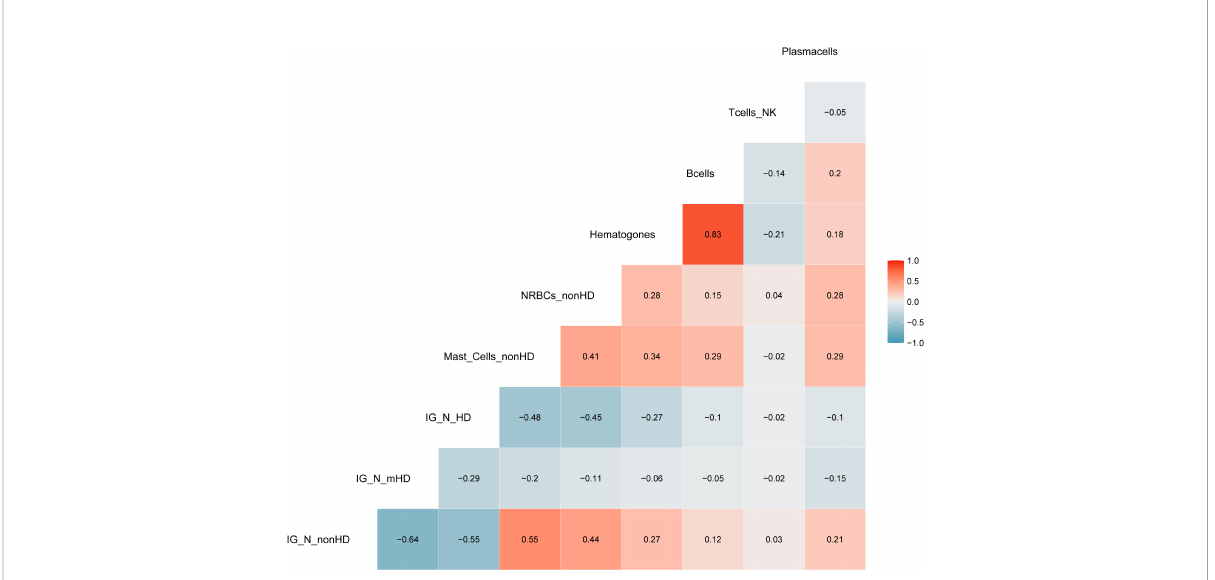
FIGURE 3 Correlation analysis with categorized parameters. Positive and negative correlations are presented in red and blue, respectively. Correlation coef fi cients are related to the color intensity. Once de fi ned the cut-offs for the three parameters (IG/N, mast cells and erythroblasts (nucleated red blood cells, NRBCs), a higher correlation was observed between these categorized variables as compared to the same continuous variables shown in Figure